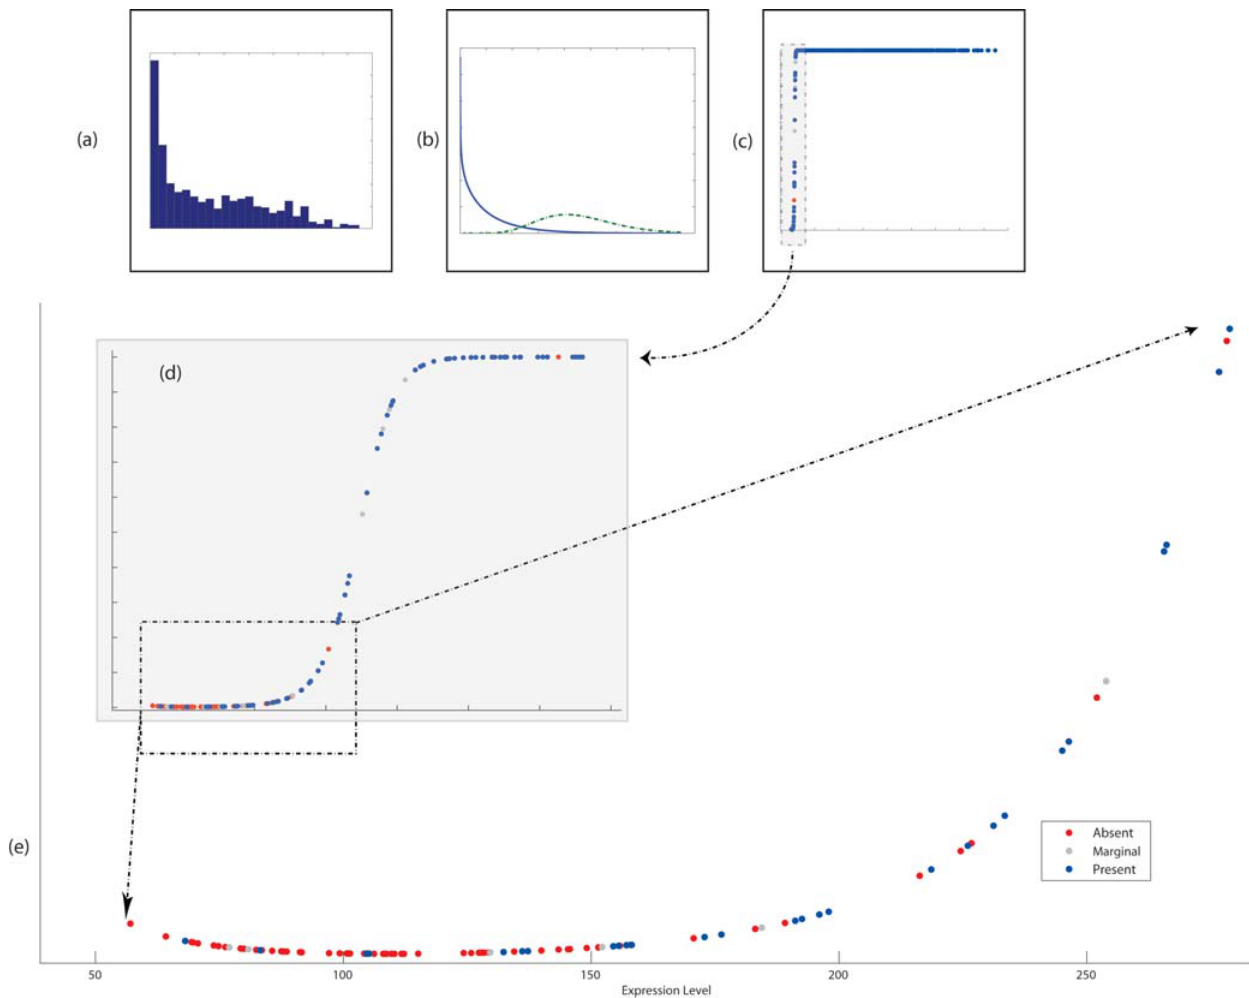
Figure 3. Similar to matching panels (a) (b) and (c) in Figure 2, panels (a), (b) and (c) of this figure show the histogram of gene expression, two resulting gamma curves, and the probability of being in an ‘‘up’’ state for a specific single probe set out of the collection of probes set in a collection of sample. Panel (d) is a zoom into the highlighted part of panel (c). Panel (e) is a zoom into the highlighted part of panel (d). Panel (d) shows the gradual probabilistic transition from being associated with a ‘‘down’’ state to being in an ‘‘up’’ state. The transition correlates well with gene expression and demonstrates the sensitivity of the approach to changes in gene expression. In panel (d) and in zoom-in panel (e), we also highlight the Present/Absent calls made by MAS5. Especially in the panel (e), it is easy to see how MAS5 Present/Absent calls toggle with growing levels of expression, despite an expected plateau, the MAS5 algorithm stabilizes on a Present call at much higher levels of expression and makes an Absent call for gene expression level as high as 500, while giving a Present call to expression level of 50. Use the toggled calls puts the user in danger of associating very different of expression level with very different states of a gene.